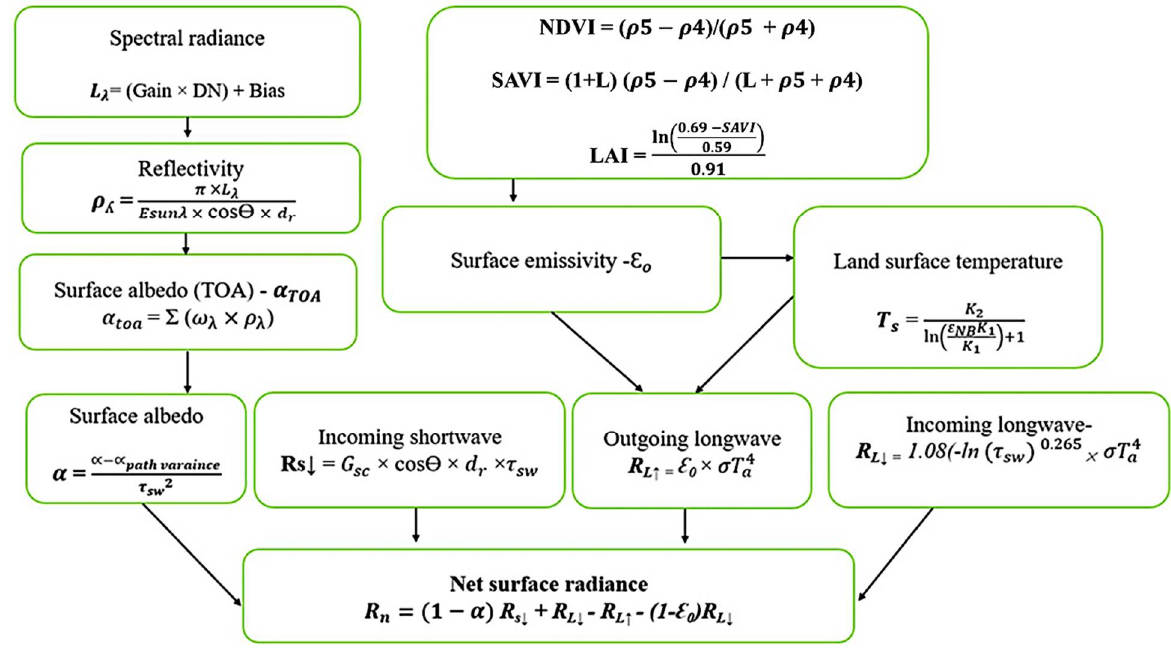
Figure 3. Flow chart of the net surface radiation computation.